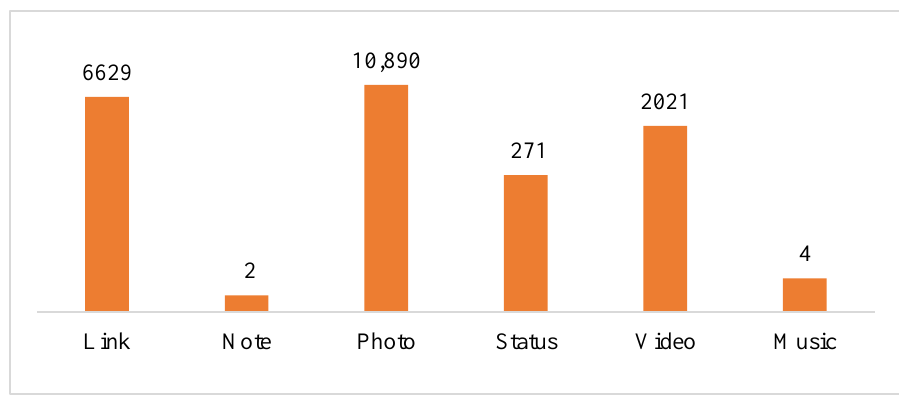
Figure 2. Number of posts by format type.